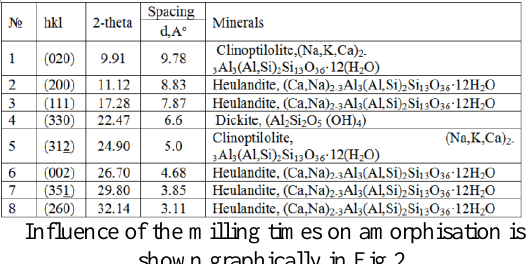
Table 1. Mineral phase identification of raw zeolite